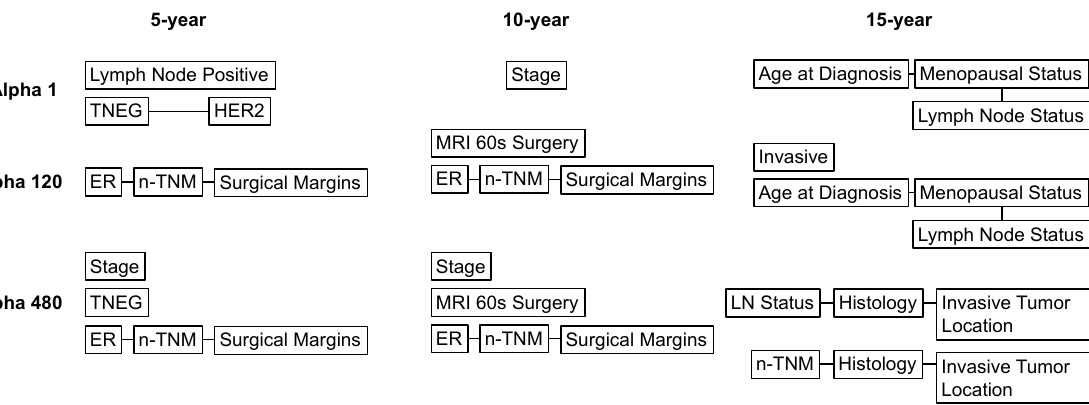
Figure 2. MBIL-generated causal sets of 5-, 10- and 15-year breast cancer metastases.